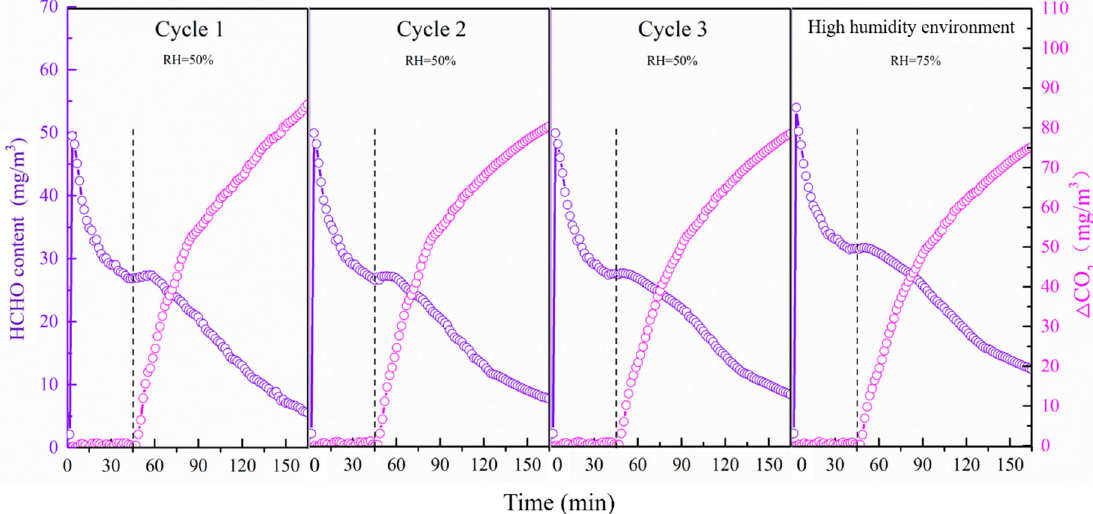
Figure 6. Repeated formaldehyde degradation performance of 40B0/CN in sunlight and its formaldehyde degradation performance in a high humidity environment.